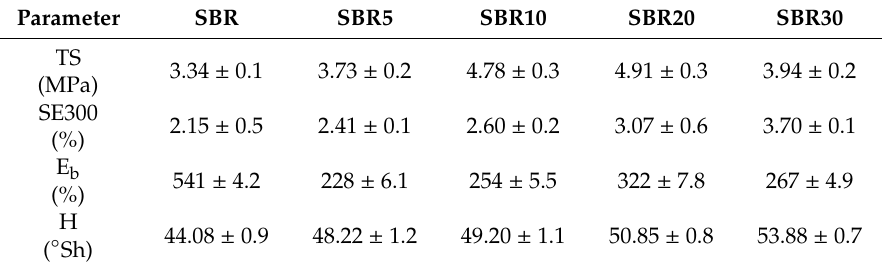
Table 3. Influence of BDC filler on the mechanical properties of SBR